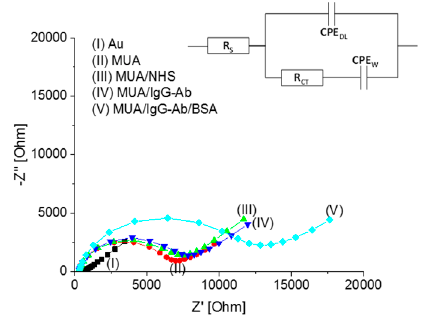
Figure 1. EIS spectra of the functionalization steps for (I) Au; (II) Au/MUA; (III) Au/MUA/Sulfo-NHS; (IV) Au/MUA/(H + L) specific-IgG-Ab; (V) Au/MUA/F(ab)2-IgG-Ab/BSA.